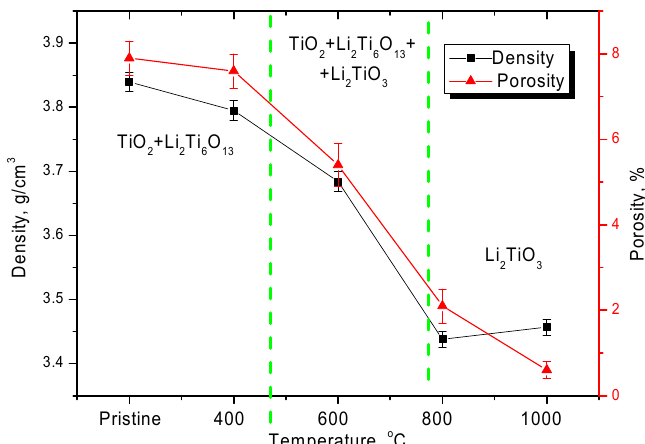
Figure 4. Graph of changes in density and porosity of ceramics depending on annealing tempera- ture.